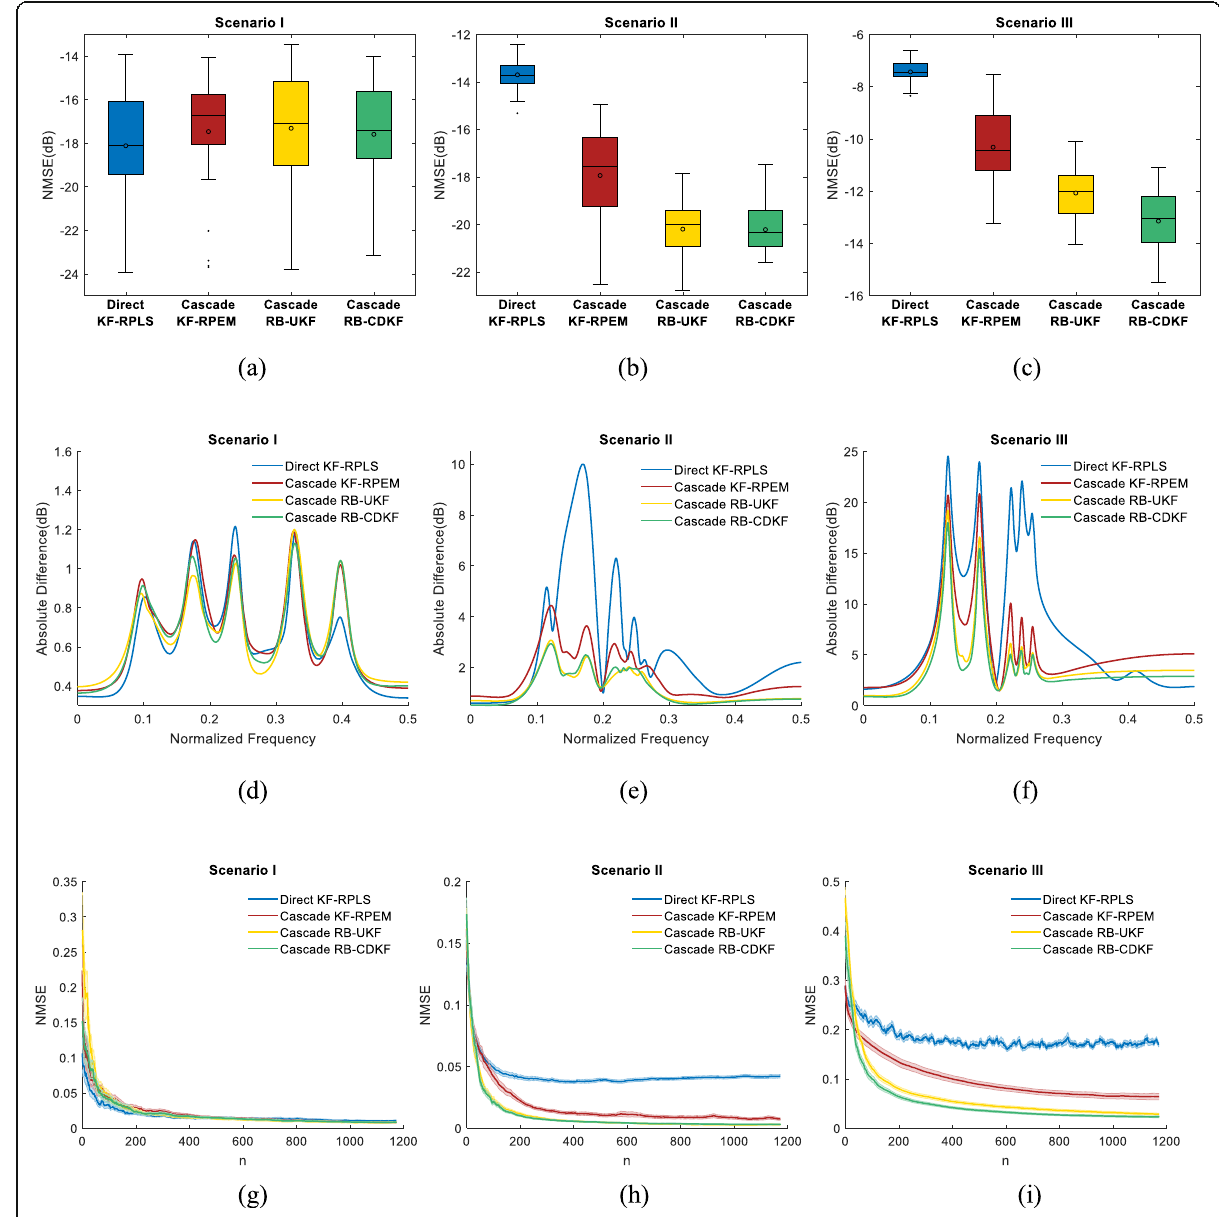
Fig. 3 NMSE (dB) boxplots (upper panel, a – c ), absolute difference between simulated and estimated PSD (middle panel, d – f ), and time evolution of NMSE (bottom panel, g – i ) for Scenario I (left panel, a , d , g ), II (middle panel, b , e , c ), and III (right panel, g , h , i ). Blue, red, yellow, and green boxplots/ curves refer to direct-form models estimated by KF-RPLS and cascade-form models estimated by KF-RPEM, RB-UKF, and